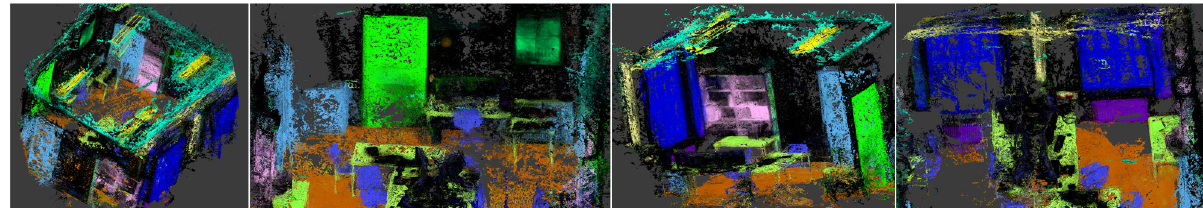
Figure 3. Different views of the generated point cloud after projection of the categories as combination of colour values. No clear distinction of categories, as the colours changed through interpolation, which is especially apparent in parts of the green